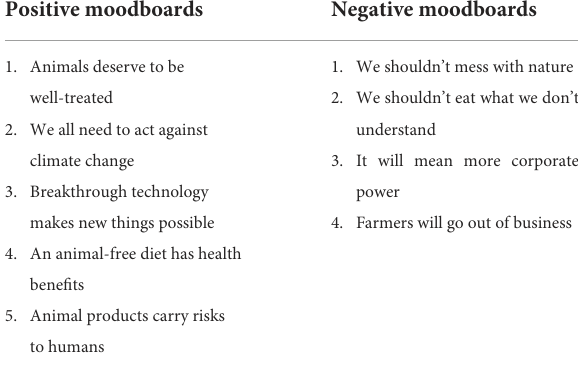
TABLE 2 Ranking frames from most to least resonant. Positive